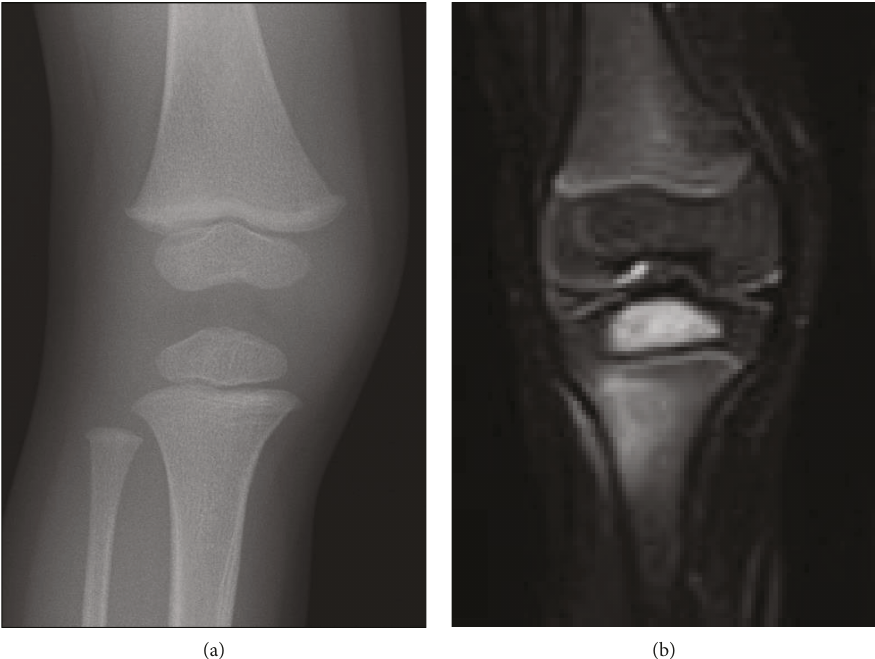
Figure 1: Initial examination. (a) Plain radiograph of the knee showing no apparent abnormalities. (b) MRI demonstrating a high-signal intensity area at the epiphysis of the right proximal tibia in the short tau inversion recovery sequence.